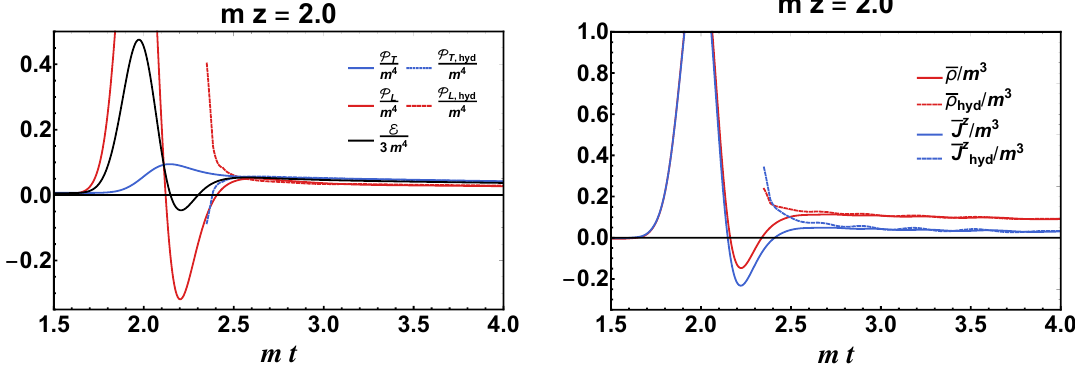
Figure 10 . Comparison of P L , P T , (cid:26) and J z for thin sheets extracted directly from simulation versus values \predicted" from the hydrodynamic constitutive relations, as described above. The calculation is done with (cid:15) = 0, (cid:21) = (cid:0) 0 : 2 and (cid:12) = 0 : 025. The calculation is done at z = 2 =m , GB meaning that the lightcone is at t = 2 =m . For completeness we also plot E .